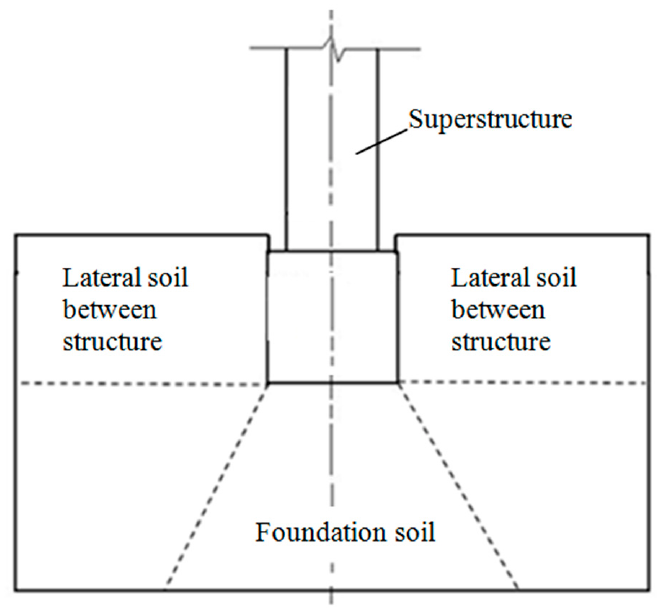
Figure 5. The schematic diagram of simplified physical model for SSI system.